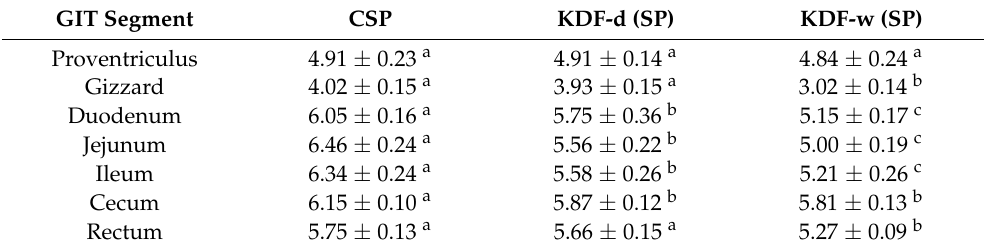
CSP: chickens supplied with non-supplemented diet and water infected with S. pullorum (n = 6); KDF-d (SP): chickens supplied with 0.5% KDF in diet infected with S. pullorum (n = 6); KDF-w (SP): chickens supplied with 0.1% KDF in drinking water infected with S. pullorum (n = 6). Significant differences in the values are marked with different characters. No significant differences in the values are marked with the same